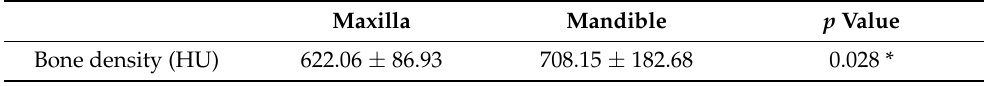
Table 1. t -test specific to the influence of arch type on the bone density (N = 52).